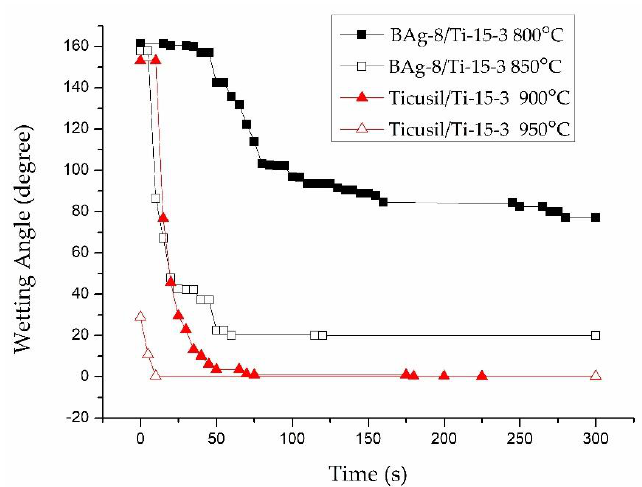
Figure 3. Wetting angles of BAg-8 and Ticusil ® on the Ti-15-3 substrate at different temperatures.